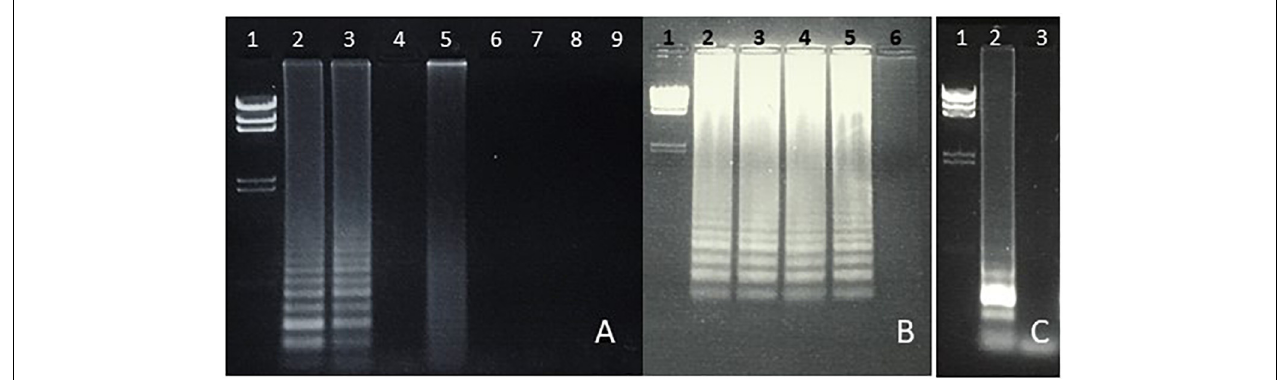
FIGURE 3 | ( A, B) Specificity of LAMP amplification of Salmonella spp. ( fimY target). (A) Lane 1, lambda Hin dIII marker. Lane 2, S. typhimurium . Lane 3, S. Newport. Lane 4, E. coli. Lane 5. Enterococcus ( Streptococcus) faecalis. Lane 6, S. aureus. Lane 7, Proteus vulgaris . Lane 8, Serratia marcescens . Lane 9, water (negative control). (B) Lane 1, lambda Hin dIII marker. Lane 2, S. typhimurium . Lane 3, S. heidelberg . Lane 4, S. enteritidis . Lane 5, S. Newport . Lane 6, water (negative control). (C) LAMP amplification of S. enteritidis ( safA target). Lane 1, Lambda Hin dIII marker. Lane 2, S. enteritidis . Lane 3,